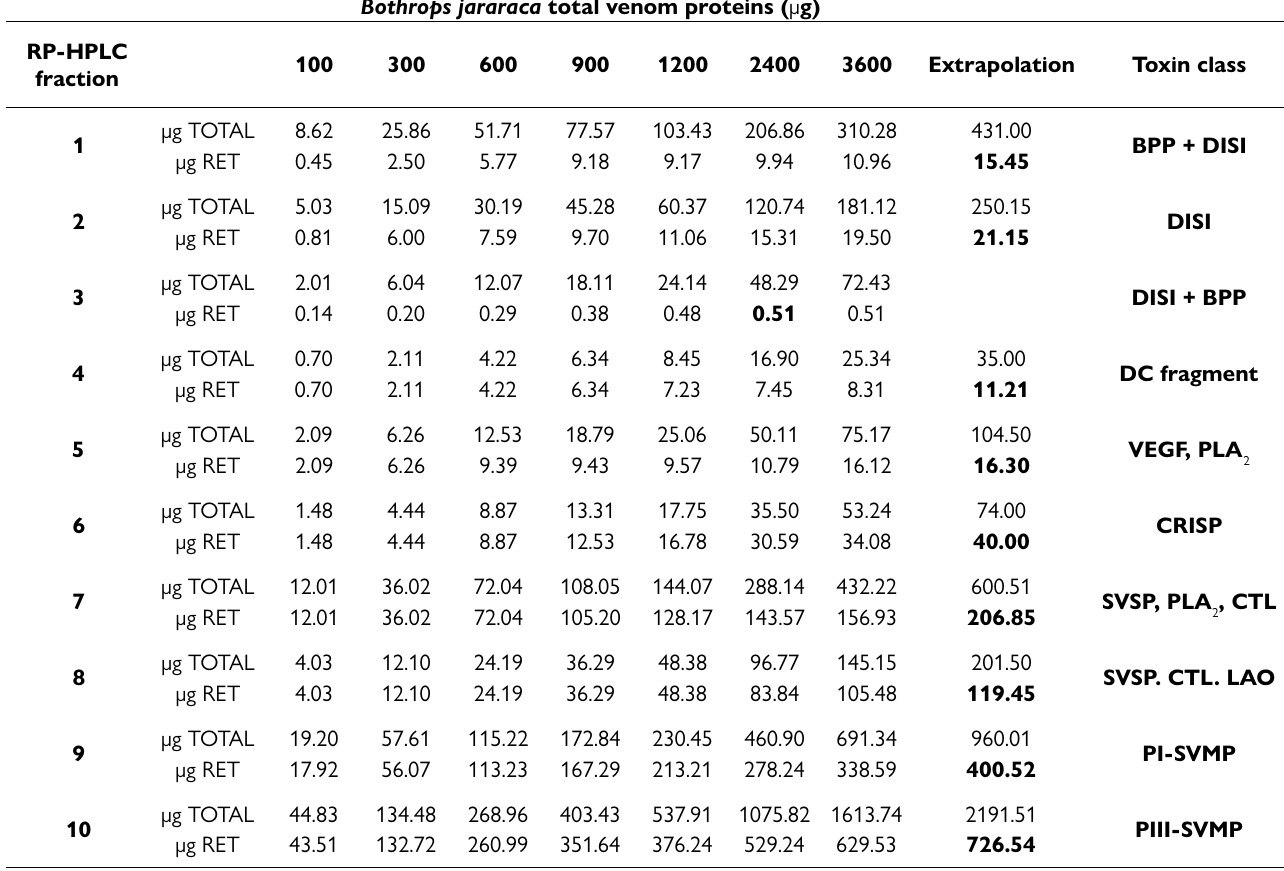
Table 2. Concentration-dependent immunoretained (RET) Bothrops jararaca (SE) (Bj) venom proteins by SAB antivenom affinity column. Maximal binding for each RP-HPLC fraction is highlighted in bold face Bothrops jararaca total venom proteins ( μ